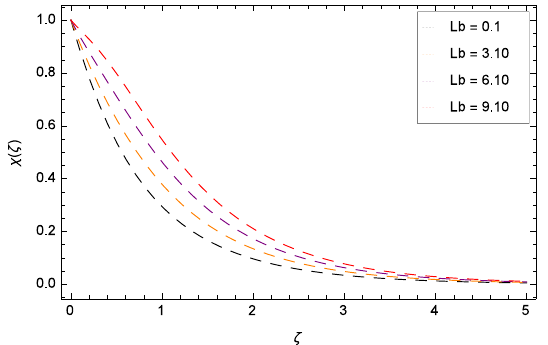
Figure 20. Pattern of graph curves on account of Lb .